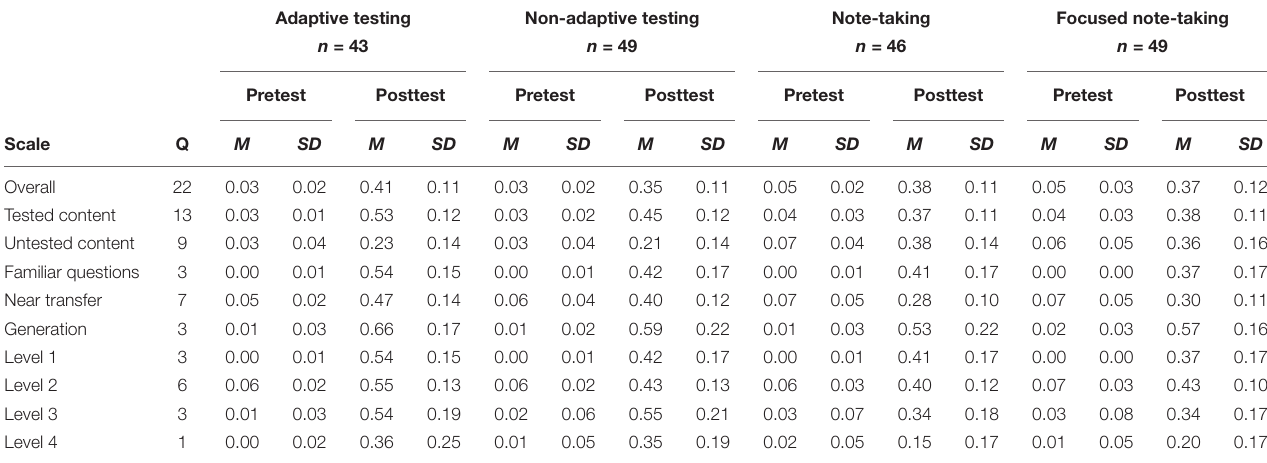
TABLE 1 | Means and standard deviations for pre- and posttest scores by scales for the adaptive testing group, non-adaptive testing group, note-taking-group, and focused note-taking group. Adaptive testing Non-adaptive testing Note-taking Focused